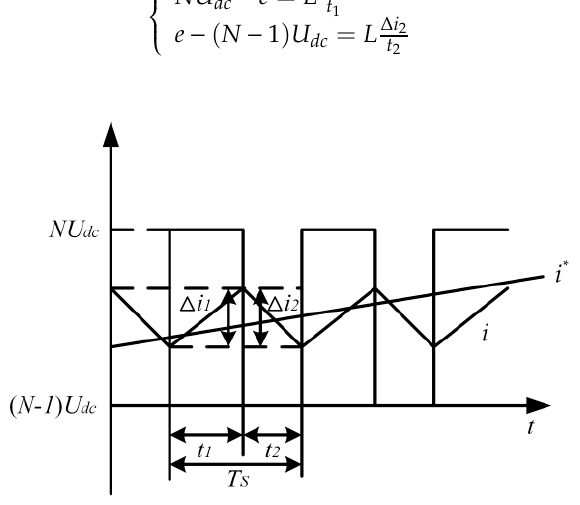
Figure 7. Current ripple at current peak.